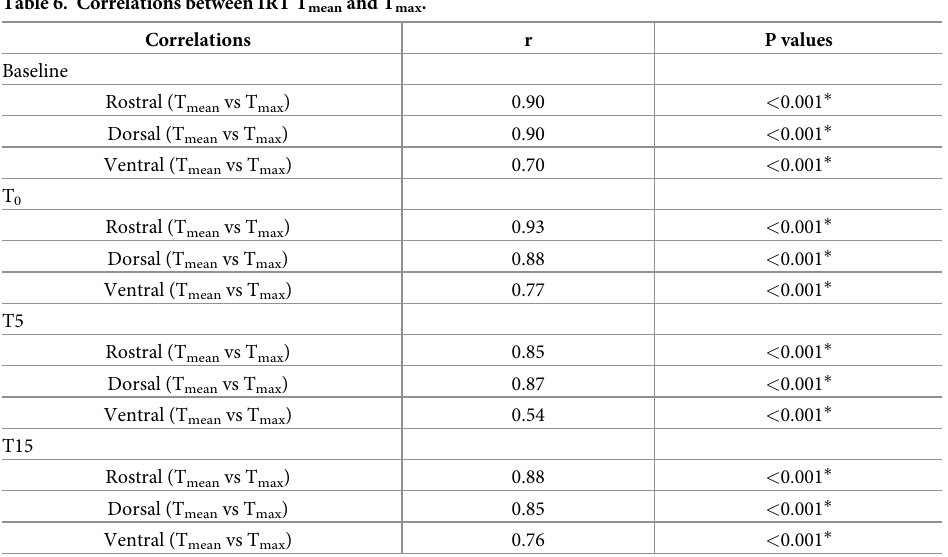
Table 6. Correlations between IRT T mean and T max . Correlations r P values Baseline Rostral (T mean vs T max ) 0.90 < 0.001 * Dorsal (T mean vs T max ) 0.90 < 0.001 * Ventral (T mean vs T max ) 0.70 < 0.001 * T 0 Rostral (T mean vs T max ) 0.93 < 0.001 * Dorsal (T mean vs T max ) 0.88 < 0.001 * Ventral (T mean vs T max ) 0.77 < 0.001 * T5 Rostral (T mean vs T max ) 0.85 < 0.001 * Dorsal (T mean vs T max ) 0.87 < 0.001 * Ventral (T mean vs T max ) 0.54 < 0.001 * T15 Rostral (T mean vs T max ) 0.88 < 0.001 * Dorsal (T mean vs T max ) 0.85 < 0.001 * Ventral (T mean vs T max ) 0.76 < 0.001 * Pearson correlation coefficients and p values are displayed for T mean vs T max IRT readings for each ROI. Dorsal and rostral ROIs showed significant strongly positive correlations between T mean and T max . The ventral ROI showed significant moderate to strong positive correlations between T mean and T max . A p < .05 is considered significant ( * ). 6-minute walk test (6MWT), immediately following 6MWT (T 0 ), 5 minutes post-6MWT (T 5 ), 15 minutes post-6MW (T 15 ), mean temperature (T mean ), maximum temperature (T max